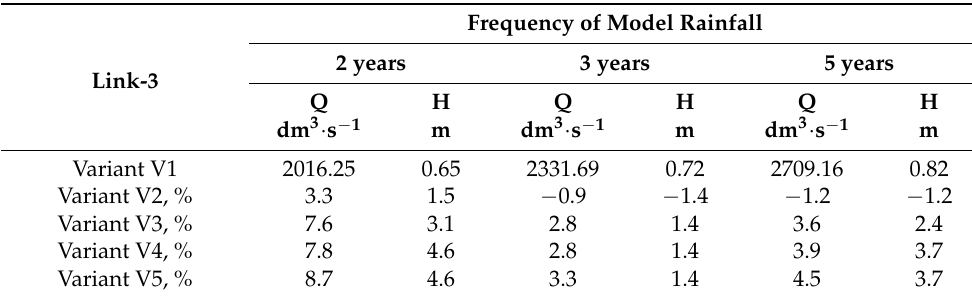
Table 2. Reduction of the maximum flow intensity and maximum depth in relation to the base variant—Link-3 calculation segment.